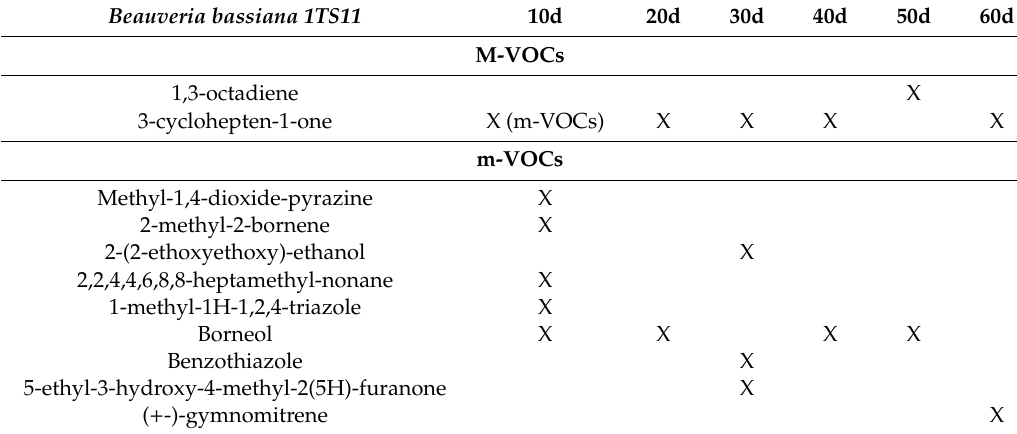
Table 3. M-VOCs and m-VOCs produced by B. bassiana 1TS11 during 60 days of growth. Abbreviations: VOC = volatile organic compound, M-VOCs = major VOCs, m-VOCs = minor VOCs, d = days after